Question: Name the type of graph shown.
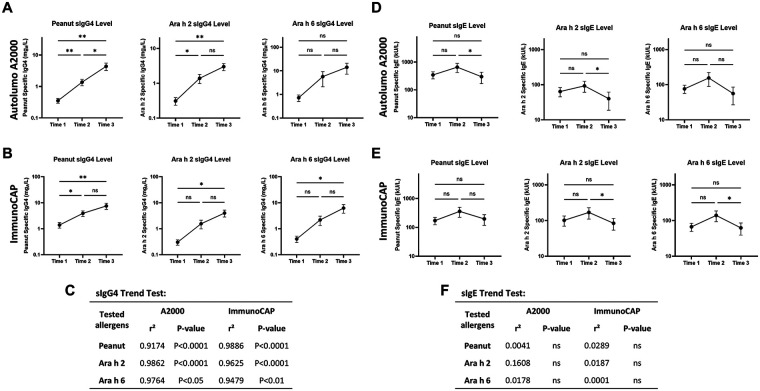
Answer: line